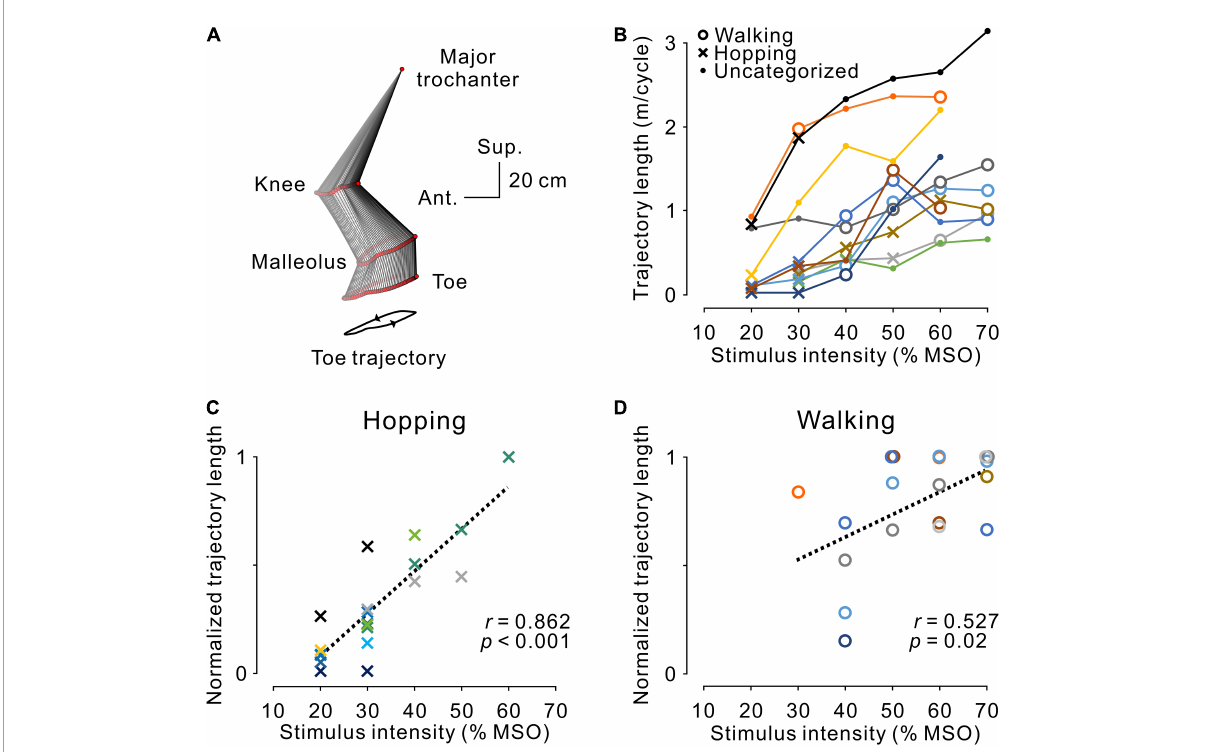
FIGURE5 Magnitude of stimulus-evoked leg movements. (A) An example of leg movements on the left side. The line with two arrowheads under the stick picture illustrates the toe trajectory. (B) The magnitude of stimulus-evoked leg movements at different stimulus intensities. Plotted data were obtained from the averaged toe trajectories in seven sequential steps. Open circles, dots, and crosses indicate hopping-like, uncategorized, and walking-like movements, respectively, as defined in Figure 3D . The relationship between stimulus intensity and the magnitude of the evoked hopping-like (C) and walking-like (D) movements. Toe trajectory length was normalized by the maximum value of each participant. Note that a linear relationship was observed during both movements (hopping-like, r = 0.923, p < 0.001; walking-like, r = 0.527, p = 0.020; Pearson’s correlation analysis). The color code of each participant is the same as in Figure 3